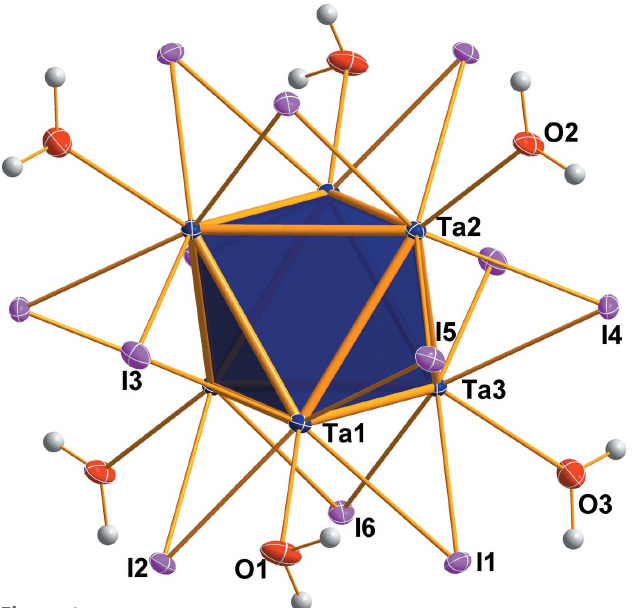
Figure 1 The centrosymmetric cluster cation [Ta 6 I 12 (H 2 O) 6 ] 2+ in the crystal structure of [Ta 6 I 12 (H 2 O) 6 ]I 2 (cid:2) 4H 2 O with the atoms shown as displacement ellipsoids at the 50% probability level. Non-labelled atoms are generated by the symmetry operation (cid:5) x + 1, (cid:5) y + 1, (cid:5) z + 1.